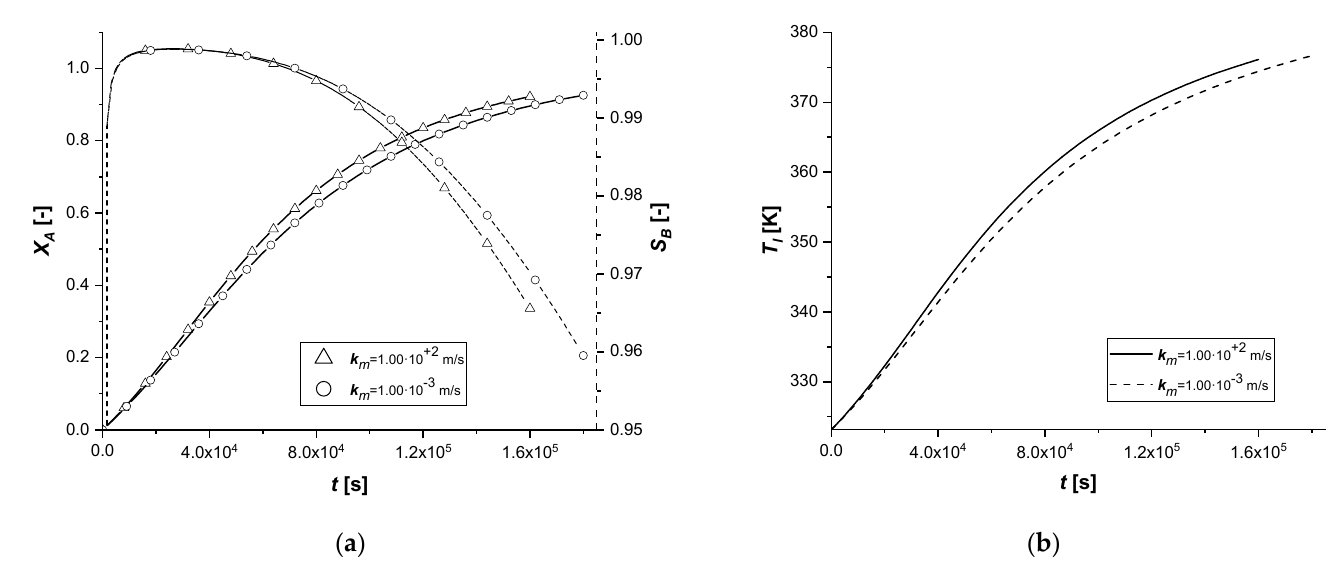
Figure 31. EY k m investigation. ( a ) Bulk profiles over time of X A and S B . ( b ) Bulk profile of T l over time.